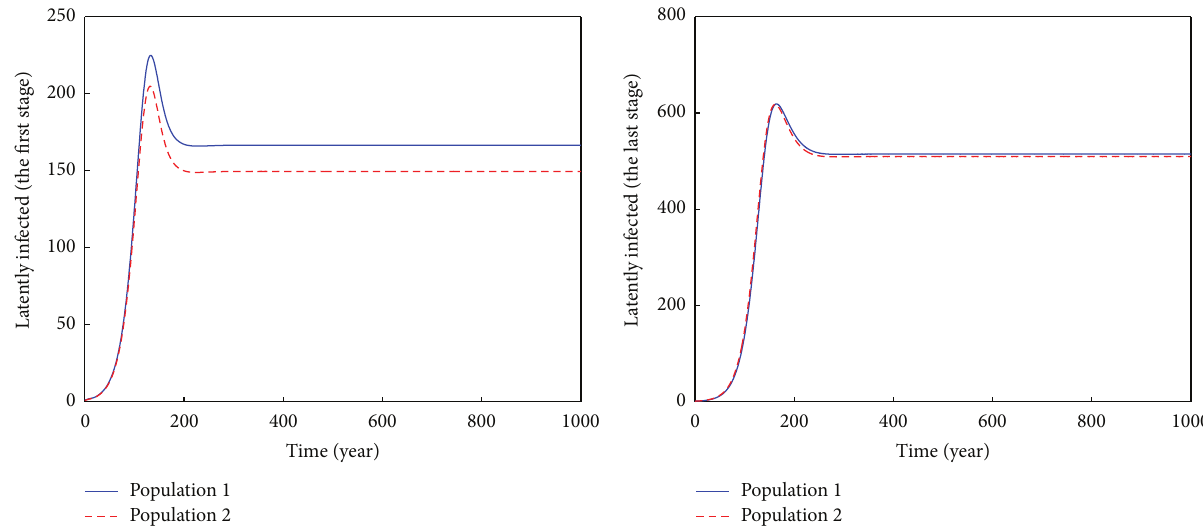
Figure 6: Trajectories of latently infected individuals of (1) for different initial conditions when 𝛽 1 = 0.822 and 𝛽 2 = 0.943 (such that = 2.3601 and 𝑅 2 = 2.4910 ). The endemic equilibrium is locally and asymptotically stable when 𝑅 𝑅 1 0 0